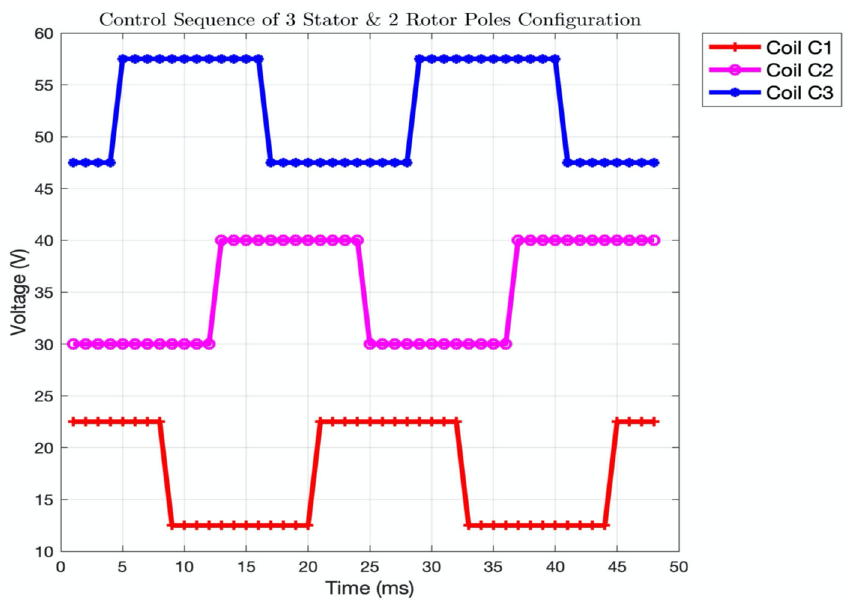
Figure 3. Magnetic polarization sequences in the three stator coils.